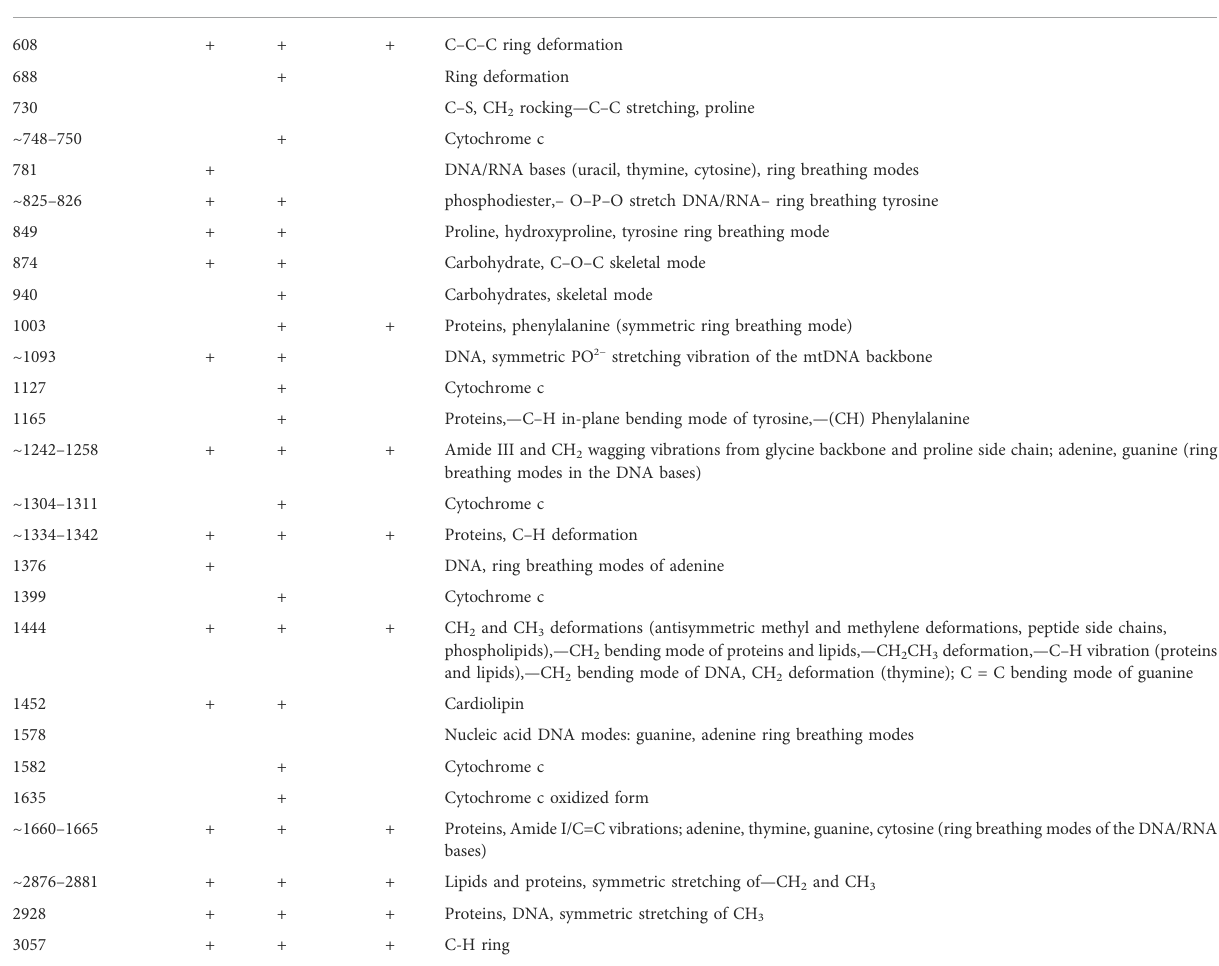
TABLE 1 Raman band assignments from the head, midpiece and tail of sperm cell. Raman band (cm − 1